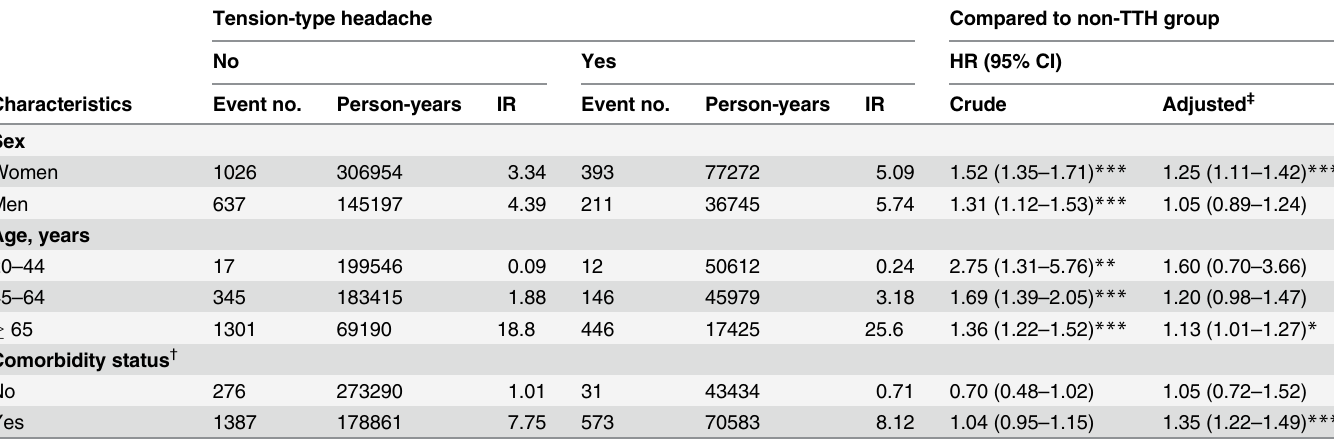
Table 3. Incidence density rates and hazard ratios of dementia according to tension-type headache status stratified by sex, age, and